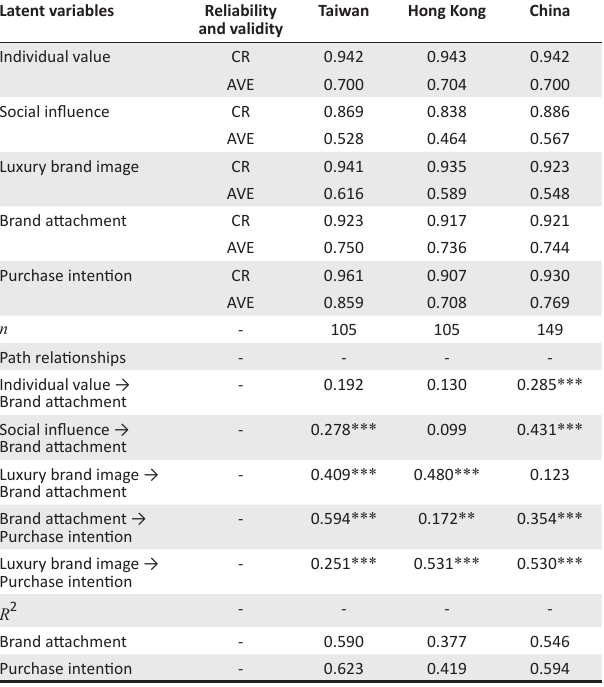
FIGURE 2: Partial least square regression results for the proposed research model. TABLE 4: Subsample-specific assessment